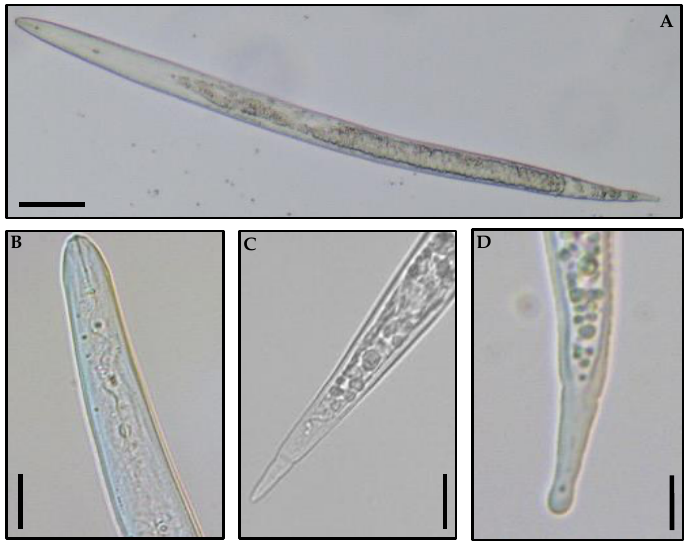
Figure 4. Meloidogyne hapla light microscope observations. Second-stage juvenile: ( A ) whole specimen; ( B ) anterior region; ( C ) tail region; ( D ) hyaline part (bar = 20 µm).